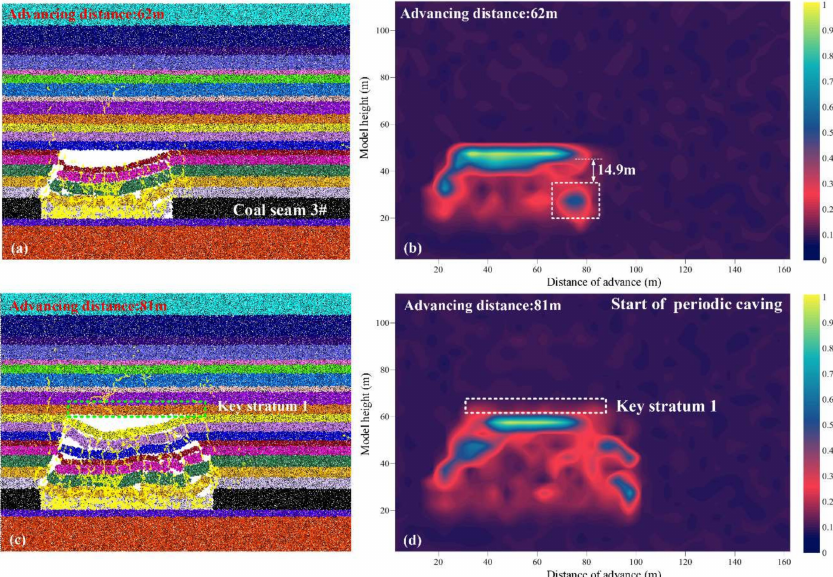
Figure 9. Dynamic evolution of cracks and porosity simulated with PFC 2D , showing change in cracks in overburden strata during heading to 62 m ( a ) and 81 m ( c ) prior to the face, and changes in porosity at 62 m ( b ) and 81 m ( d ). The changes in porosity level are denoted by the change in color scale through the corresponding numerical